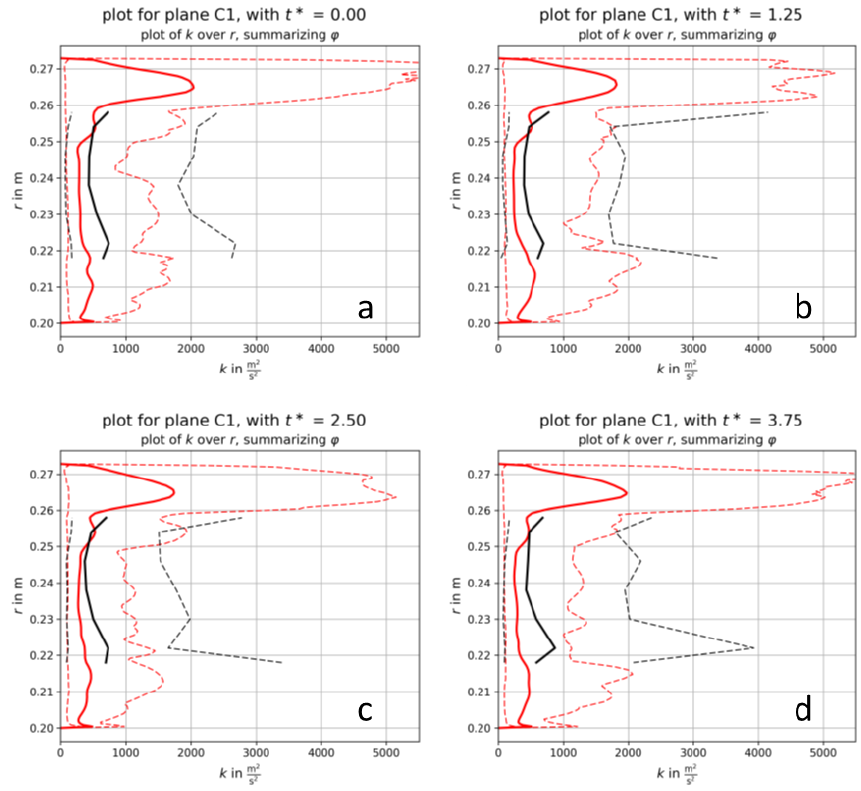
Figure 11. Comparison of instantaneous measured ( left ) and computed ( right ) turbulence kinetic energy in plane C1 after the rotor (view in upstream